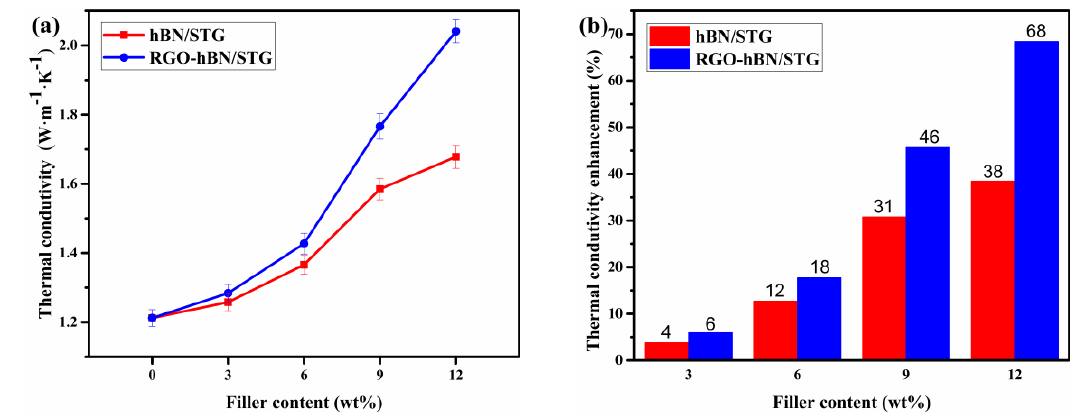
Figure 5. ( a ) Thermal conductivity of hBN / STG and RGO-hBN / STG with di ff erent filler contents, and ( b ) the corresponding thermal conductivity enhancement.